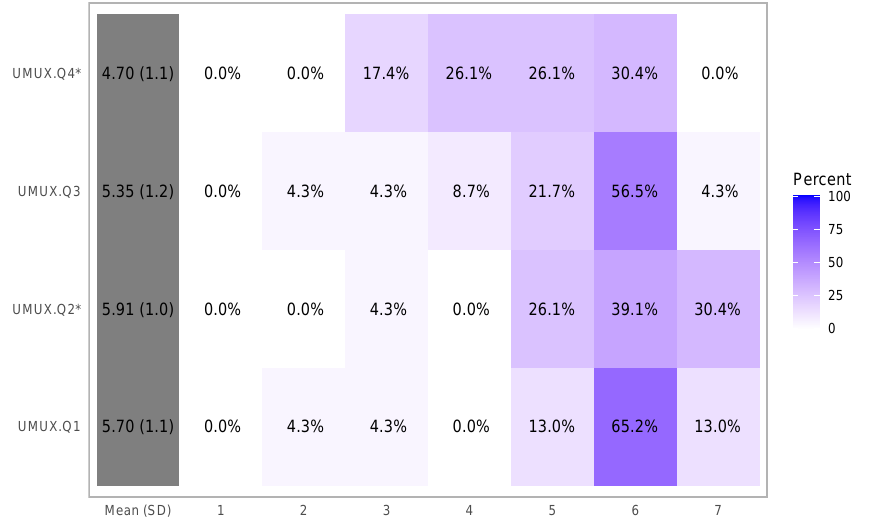
Figure 8. Results of the UMUX questionnaire. Rates assigned to negative questions have already been